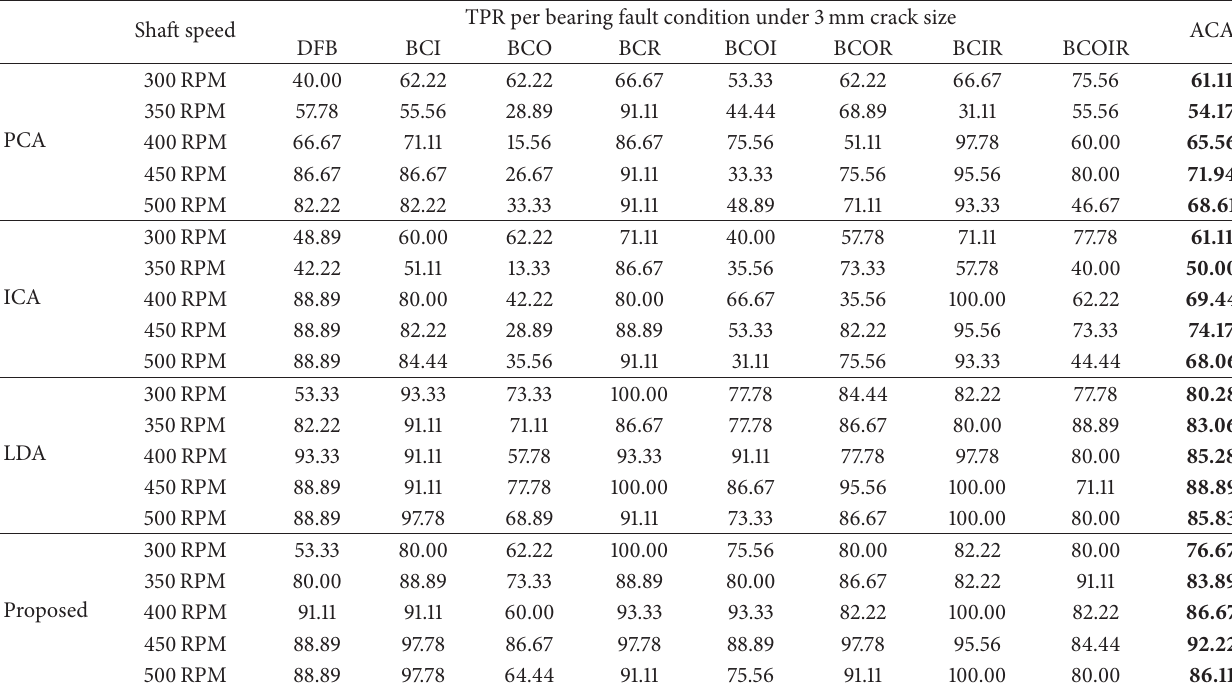
Table 5: Performance comparison between conventional feature analysis approaches and the proposed feature analysis method in terms of the average classification accuracy and the true positive rate at a bearing crack size of 3 mm (unit: